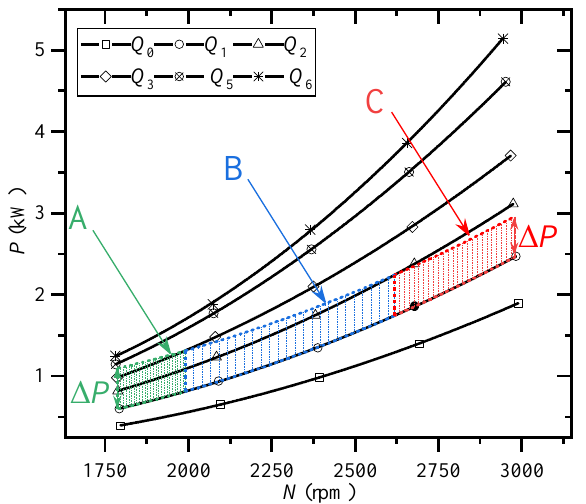
Figure 10. Variation of estimation for different working points.